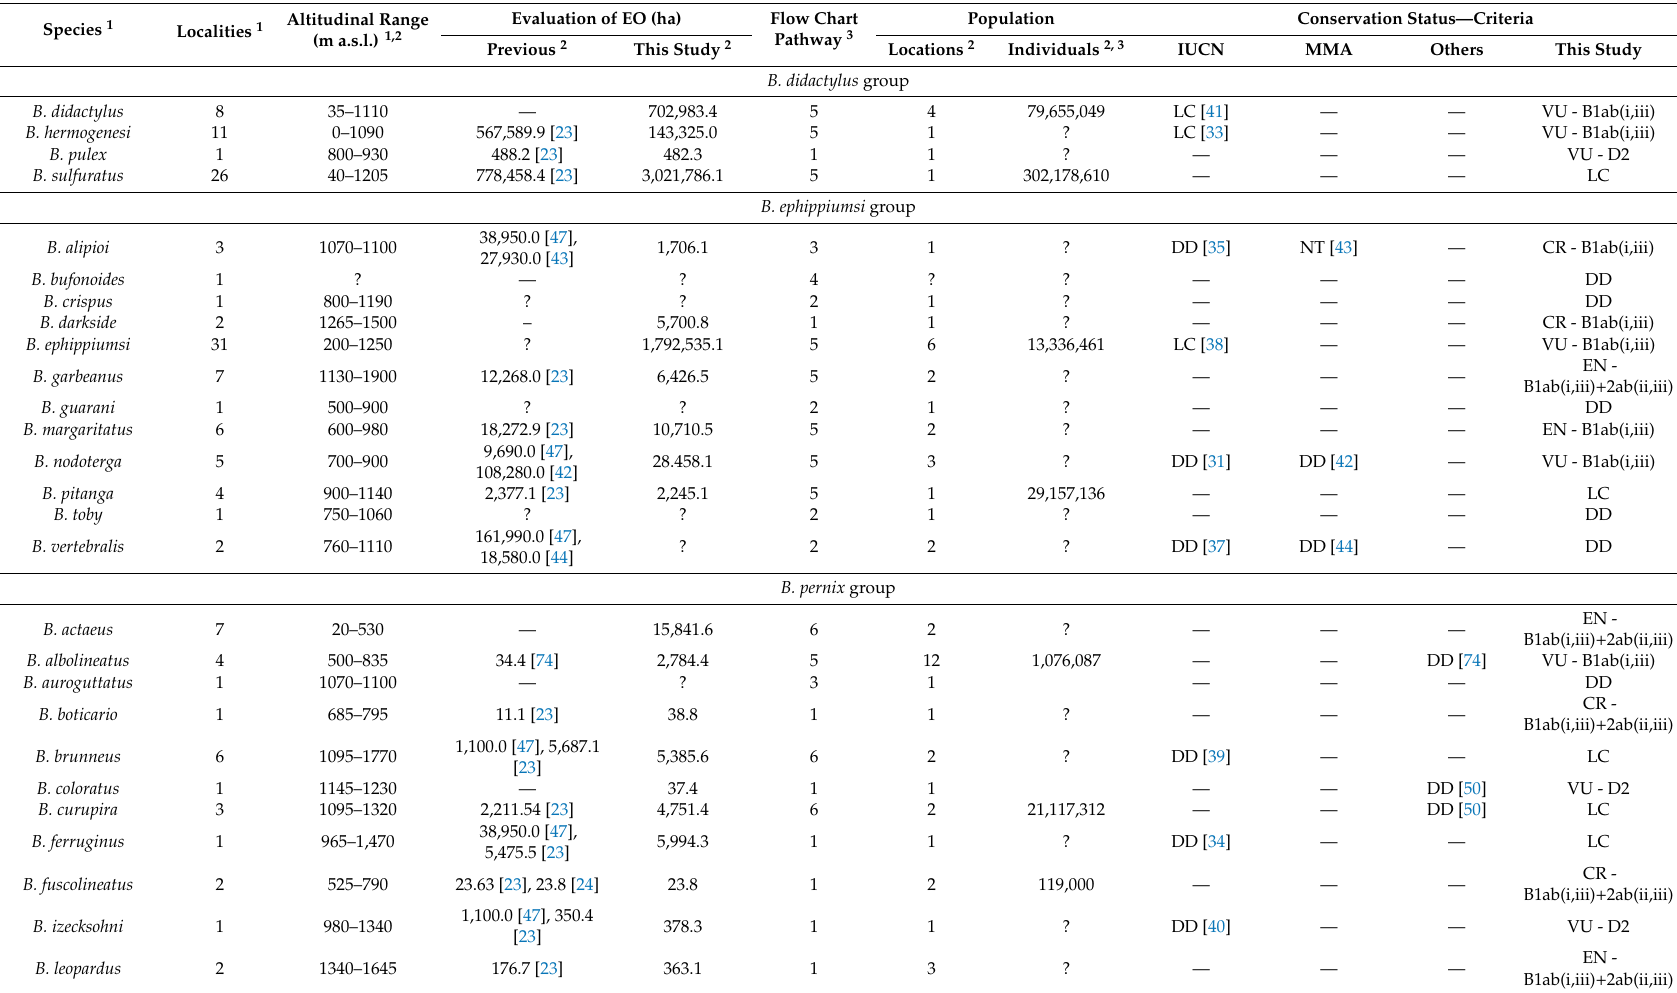
Table 2. Status of conservation of identified species of Brachycephalus according to IUCN [48]. Abbreviations: EO = extent of occurrence (see text for details); MMA = Minist é rio do Meio Ambiente